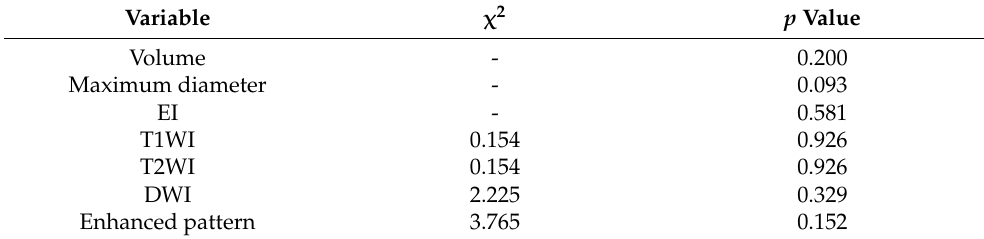
Table 9. Univariate analysis of PFS2 with radiological